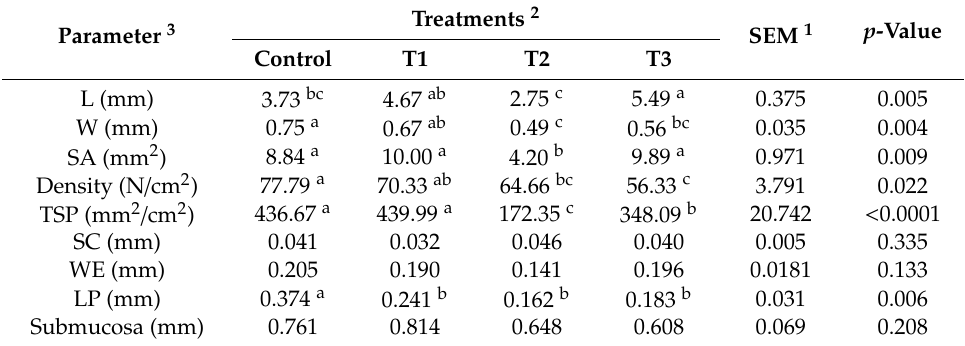
Table 5. E ff ect of treatments on histomorphometric of the rumen of the growing Naemi lambs (the end of the experiment).